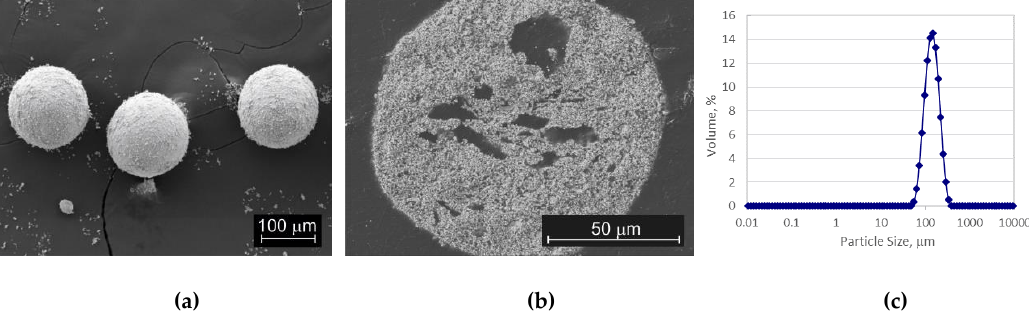
Figure 1. Degassed and pre-sintered WC-6 wt.% Co powder (WC6Co): Secondary electron SEM images of ( a ) the particles, ( b ) internal structure and ( c ) particle size distribution.